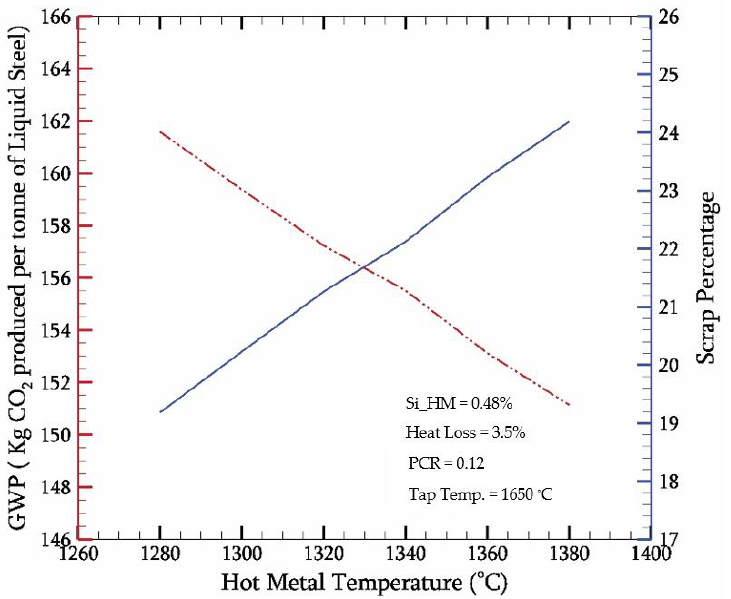
Figure 7. Effect of hot metal temperature on GWP of the process for a given PCR = 0.12, tapping temperature, silicon level, and heat loss.